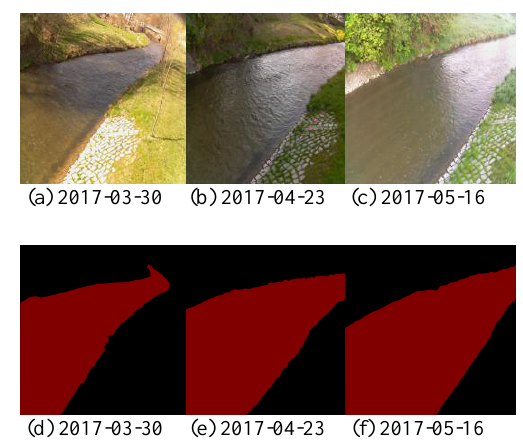
Figure 2. Examples of original and labelled images from the